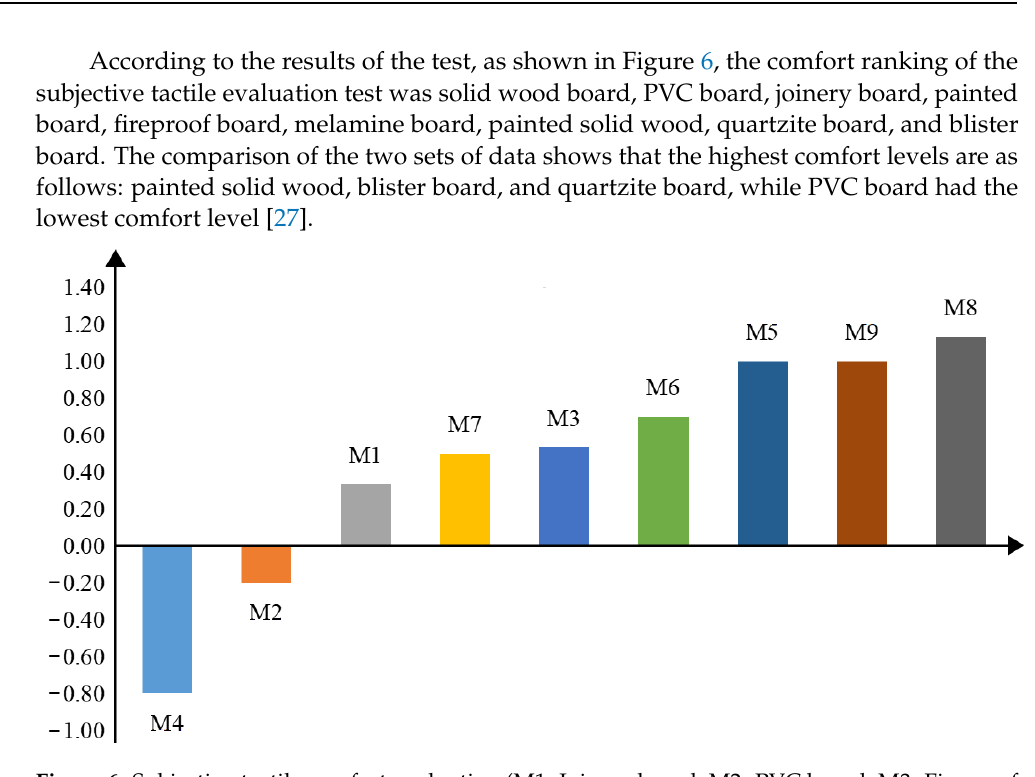
Figure 7. Material surface roughness (M1: Joinery board, M2: PVC board, M3: Fireproof board, M4: Solid wood board, M5: Painted solid wood board, M6: Melamine board, M7: Painted board, M8: Blister board, M9: Quartz board). According to the results of the test, as shown in Table 3 and Figure 8, blister board had the lowest rate of surface cooling, while the solid wood had the highest rate of surface cooling. In all, the rates of surface cooling of each sample, in descending order, were as follows: blister board, quartzite board, melamine board, fireproof board, painted solid wood board, painted board, PVC board, joinery board, and solid wood board.